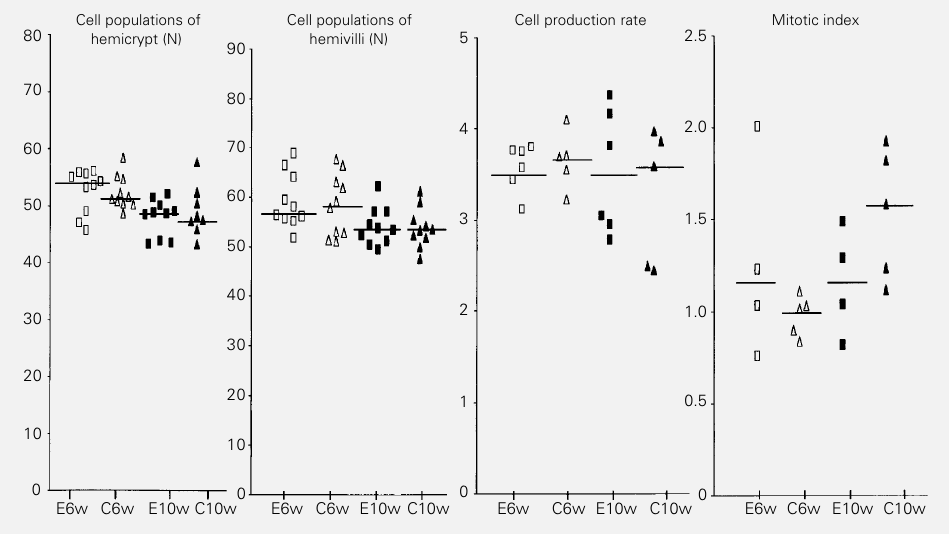
Figure 2 - Anemia and recovery from anemia had no effect on hemicrypt and hemivilli cell number or on cell production rate or mitotic index. Groups are the same as identified in the leg- end to Figure 1. The median val- ues are given by the horizontal bars. There were no significant differences among groups (non- parametric Mann-Whitney